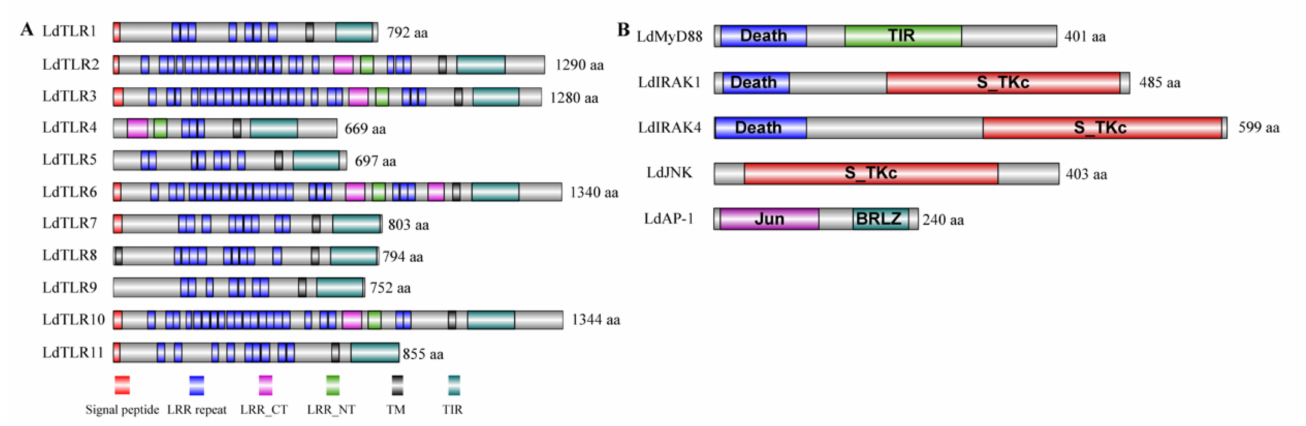
Figure 1. ( A ) The predicted protein domain architecture of the 11 Toll-like receptor genes from L. dispar . The various TLR genes contain numerous extracellular leucine-rich repeats (LRRs) domains, leucine-rich repeats C-terminal (LRR-CT), leucine-rich repeats N-terminal (LRR-NT), signal peptides, a transmembrane domain (TM) and toll-interleukin 1 receptor (TIR) domain. ( B ) Domain architecture of downstream TLR pathway components of L. dispar including LdMyD88, LdIRAK1, LdIRAK4, LdJNK and